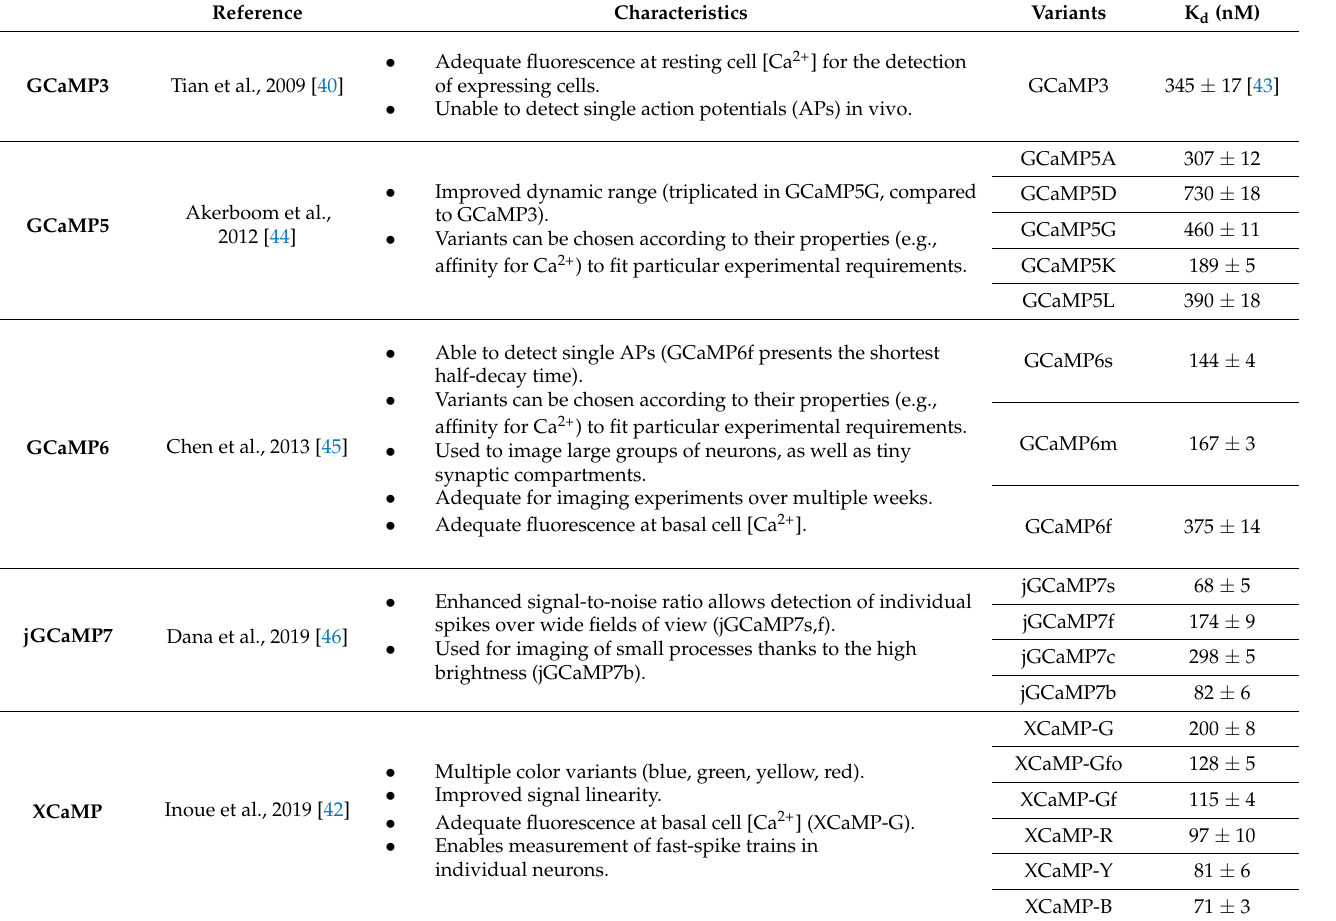
Table 1. Examples of the most common GCaMP sensors used for Ca 2+ imaging and relative affinity for Ca 2+ (K d